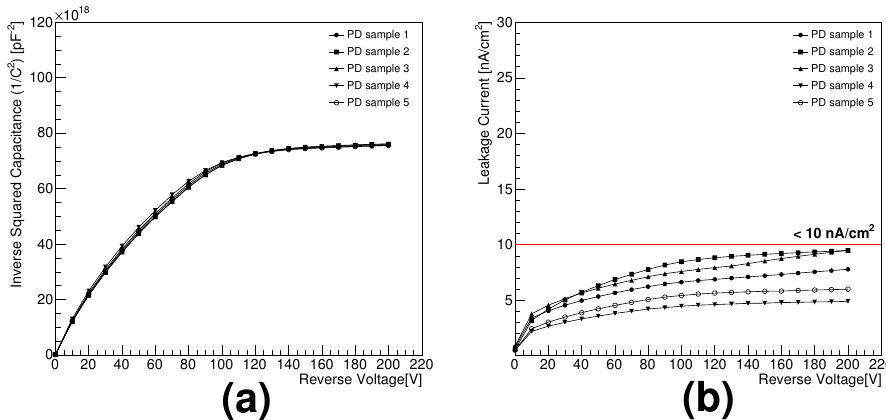
Figure 3. Electrical Characteristics of Manufactured Photodiodes As Functions of Reverse Bias Voltage: ( a ) Inverse Squared Capacitance and ( b ) Leakage Current.